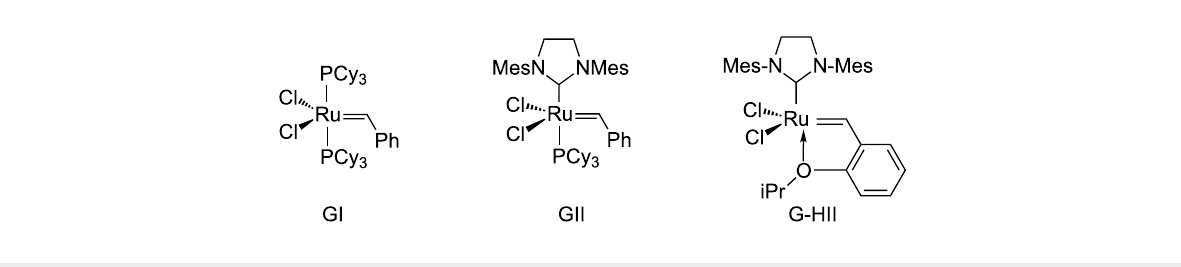
Figure 1: Some ruthenium catalysts for metathesis reactions.